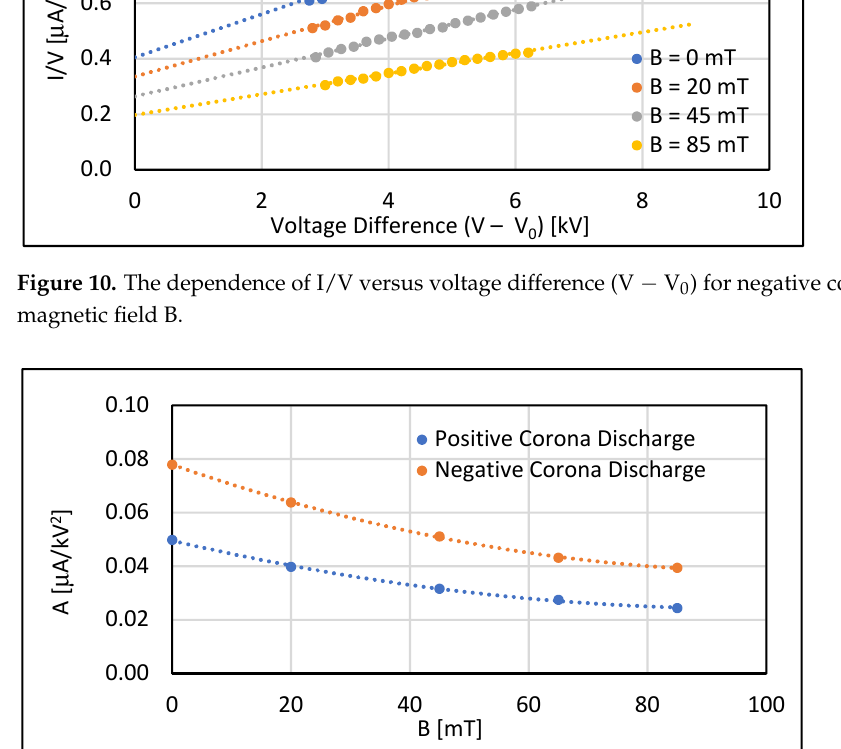
Figure 10. The dependence of I/V versus voltage difference (V − V 0 ) for negative corona at various magnetic field B.